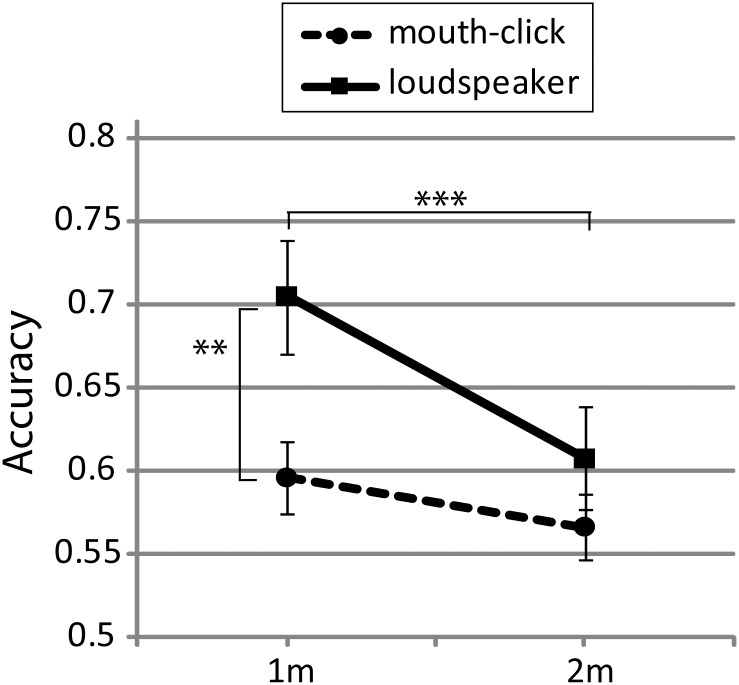
Performance split by distance and sound.Error bars represent SEM across participants. ** p< .01; *** p<.001.